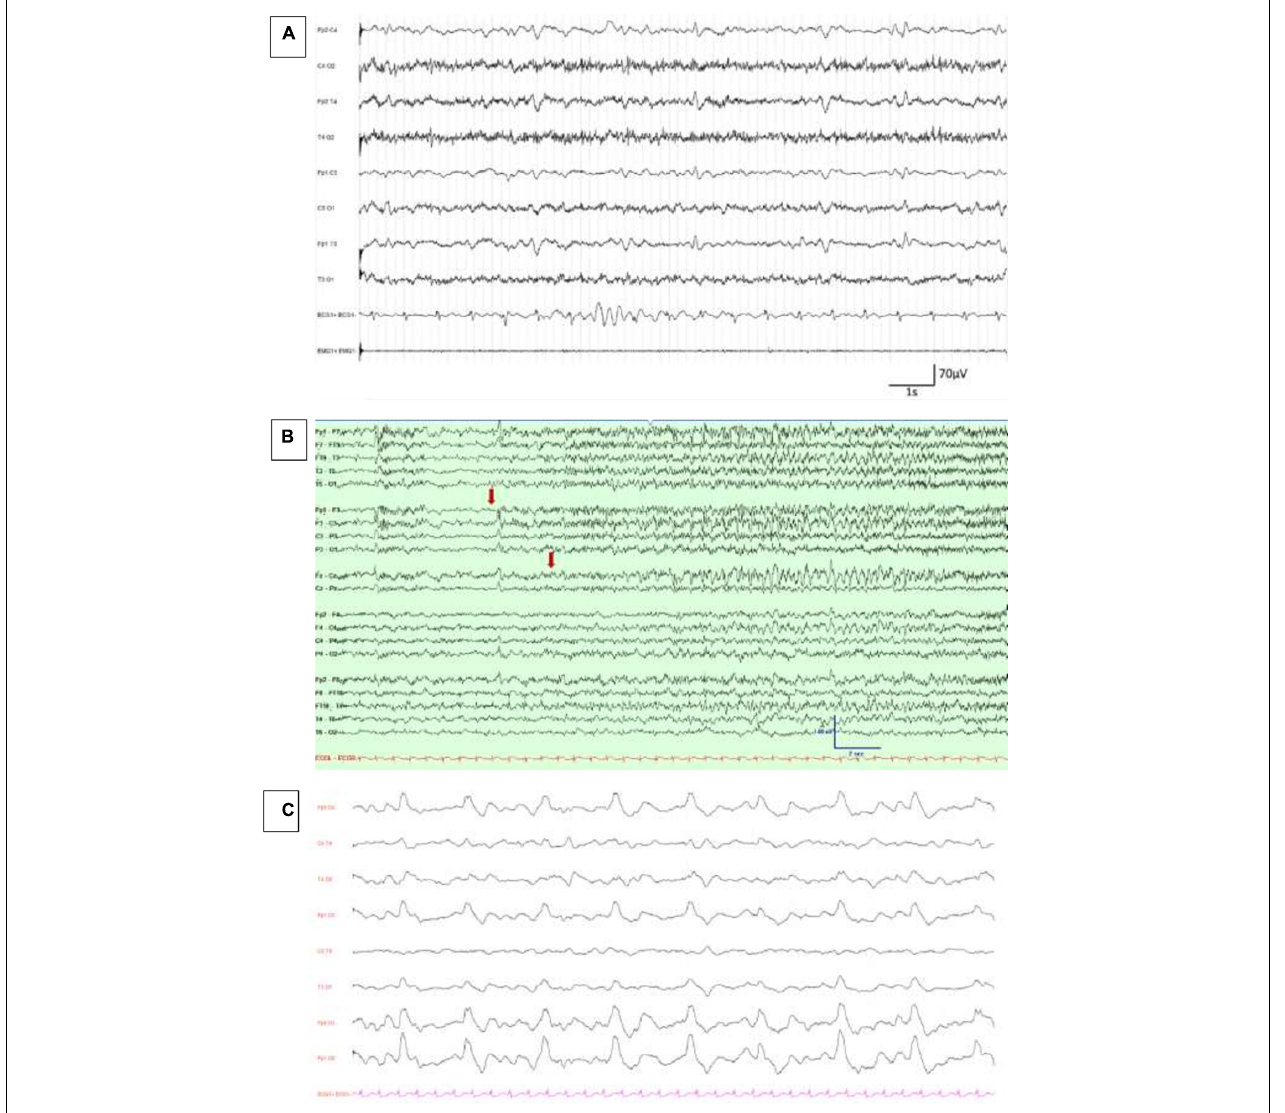
FIGURE 1 | EEG findings in COVID-19 patients. (A) Diffuse theta–delta slowing and continuous generalized periodic discharges, reproduced with authors’ agreement from Petrescu et al. (2020). (B) Emergence of low-amplitude ictal fast rhythmic activity over left frontocentral and midline regions (marked with an arrow), reproduced with authors’ agreement from Somani et al. (2020). (C) Continuous, periodic, monomorphic diphasic, delta slow waves over both frontal areas, published in Vellieux et al.